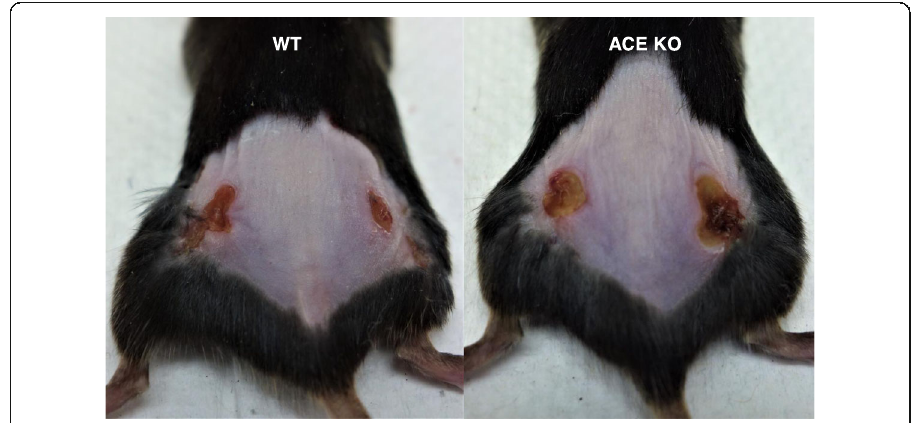
Fig. 2 ACE affects anti-bacterial defense. In mice, ACE knockout suppressed bacterial resistance. Representative images showing MRSA skin lesion at day 4 post-bacterial subcutaneous injection (1×10 7 CFU/mouse flank) [Cao D-Y et al. Unpublished